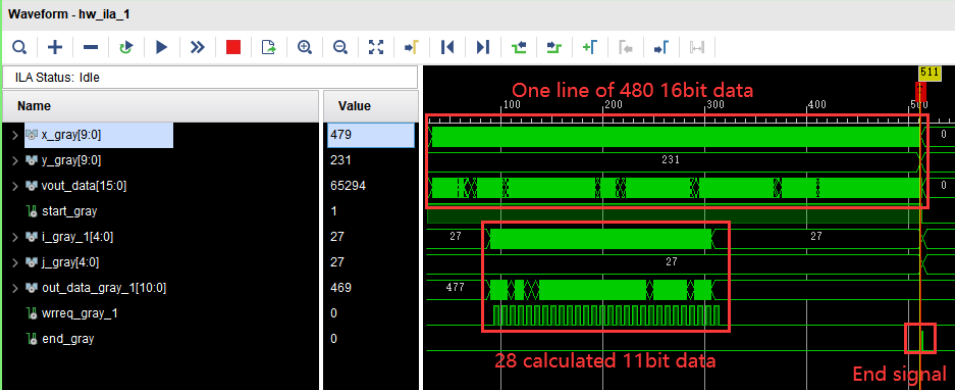
Figure 6. Simulation diagram of image